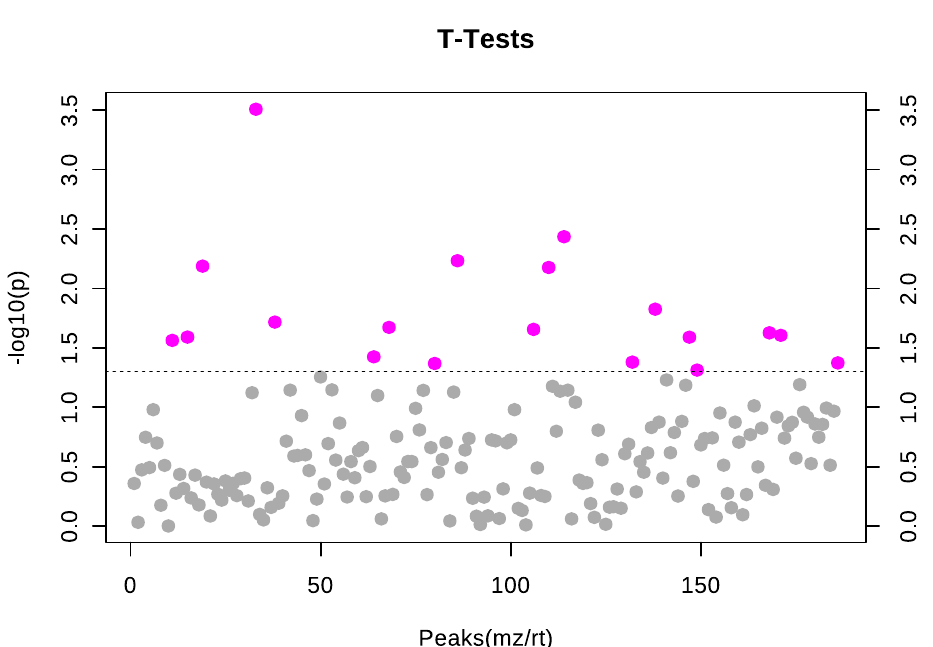
Figure 1. T-test of the peaks (mz/rt) identified in samples of Moringa oleifera extracts. Pink dots represent the m / z ratios that were statistically different when the plants were amended with vermicompost as compared to an unamended control group.